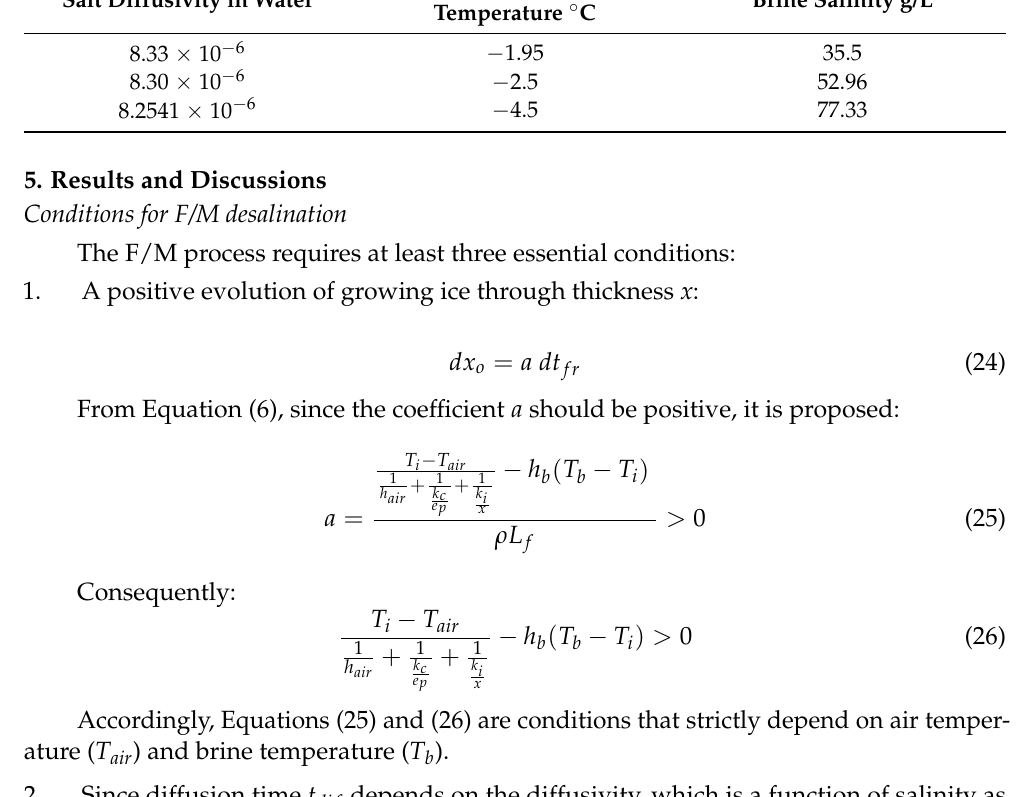
Table 1. Values obtained for the diffusivity of salt in water, temperature, and salinity. Salt Diffusivity in